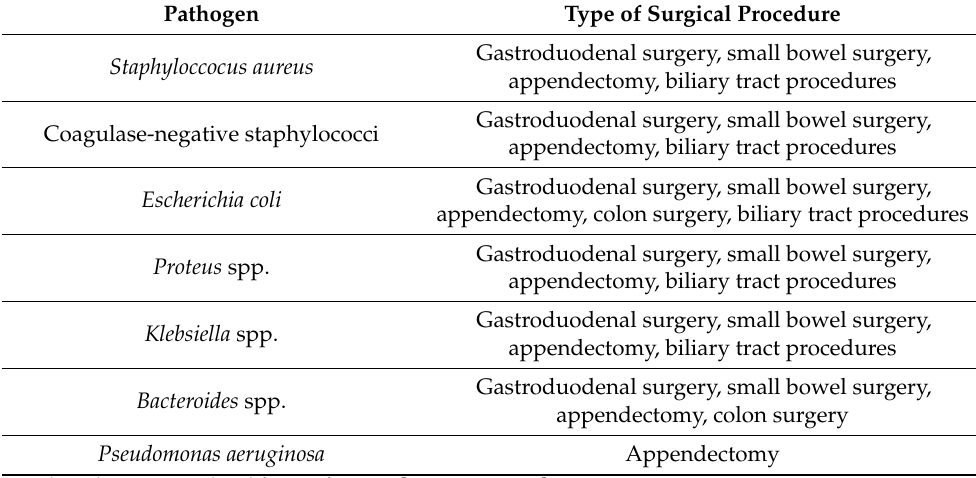
Table 1. Main aetiologic agents according to the type of abdominal surgical